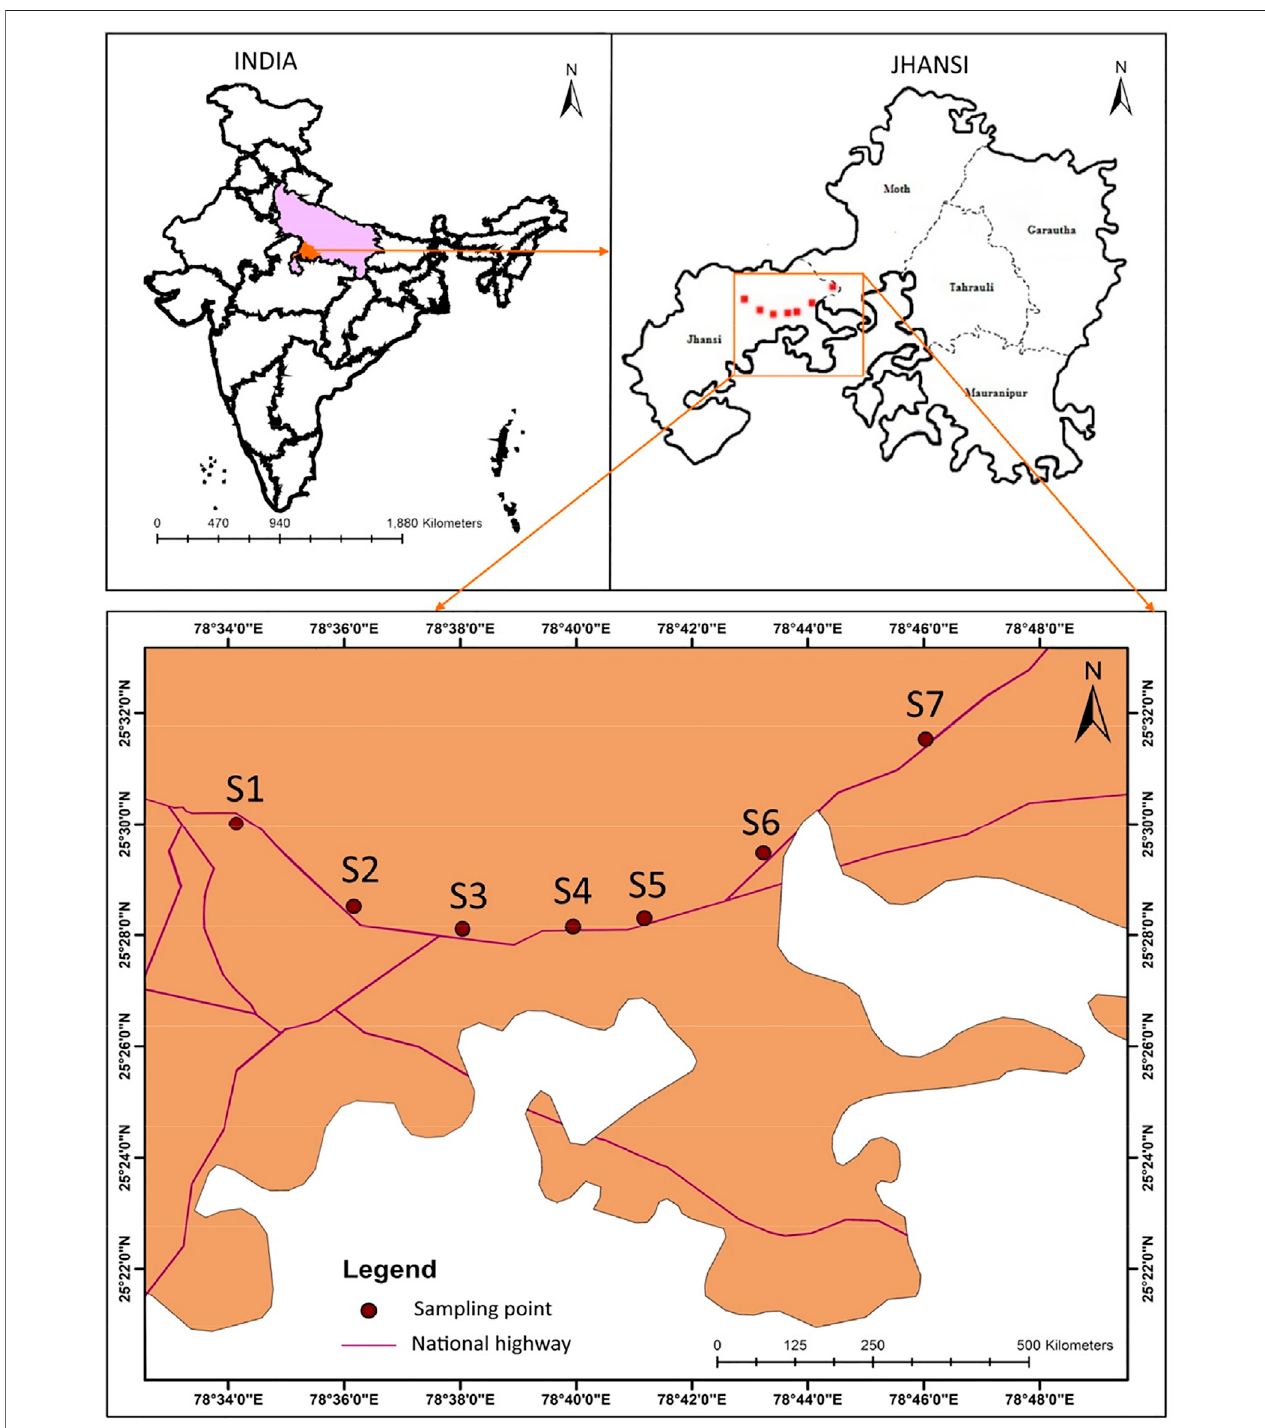
FIGURE 1 | A map of study area showing the locations of sampling